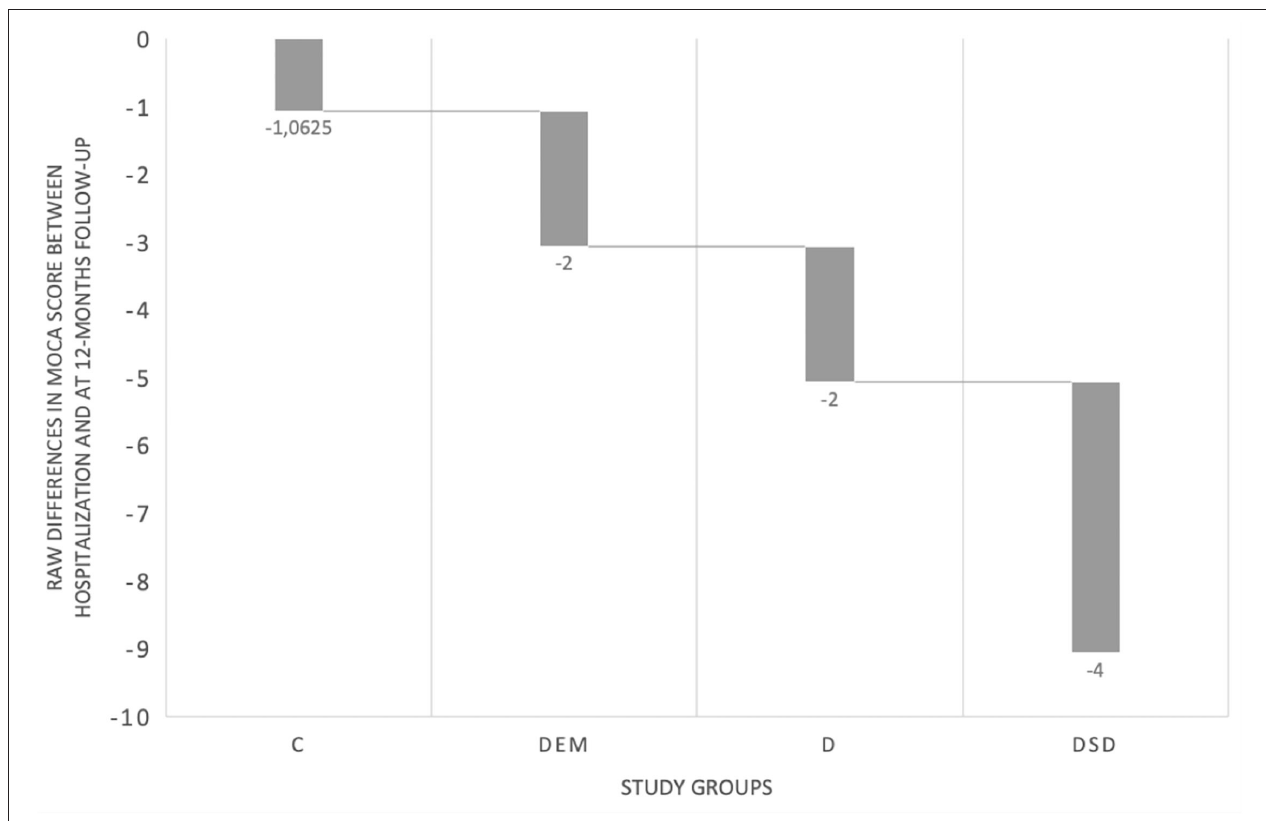
FIGURE 3 | MoCA scores mean change in the four study groups.